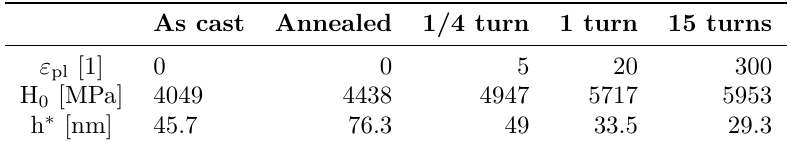
Table 1. List of the samples - equivalent plastic strain ε limit of infinite depth H